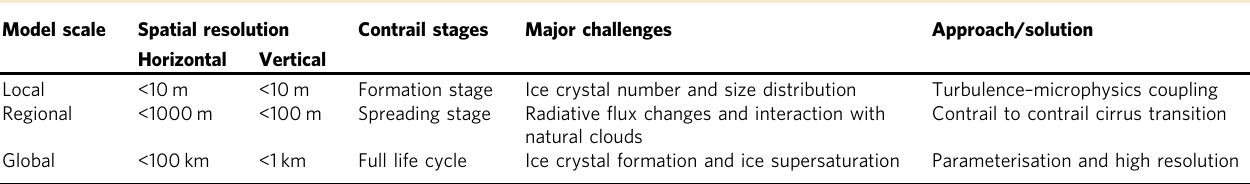
Table 2 Challenges in modelling radiative forcing due to aircraft-induced clouds Model